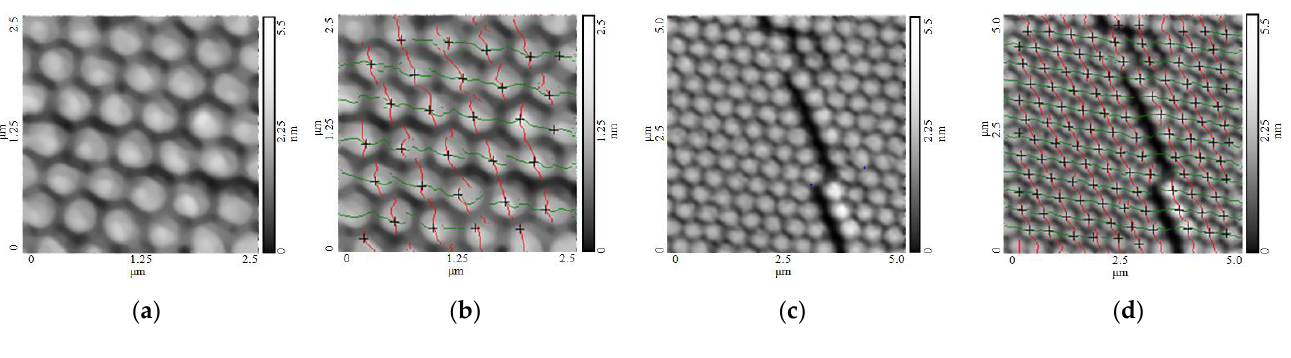
Figure 10. Images of polystyrene spheres coated by gold: ( a ) source images 2.5 × 2.5 µ m; ( b ) images with marked centres; ( c ) source images 5 × 5 μ m; ( d ) images with marked centres. Table 3. Detection results on images with different particle concentrations.